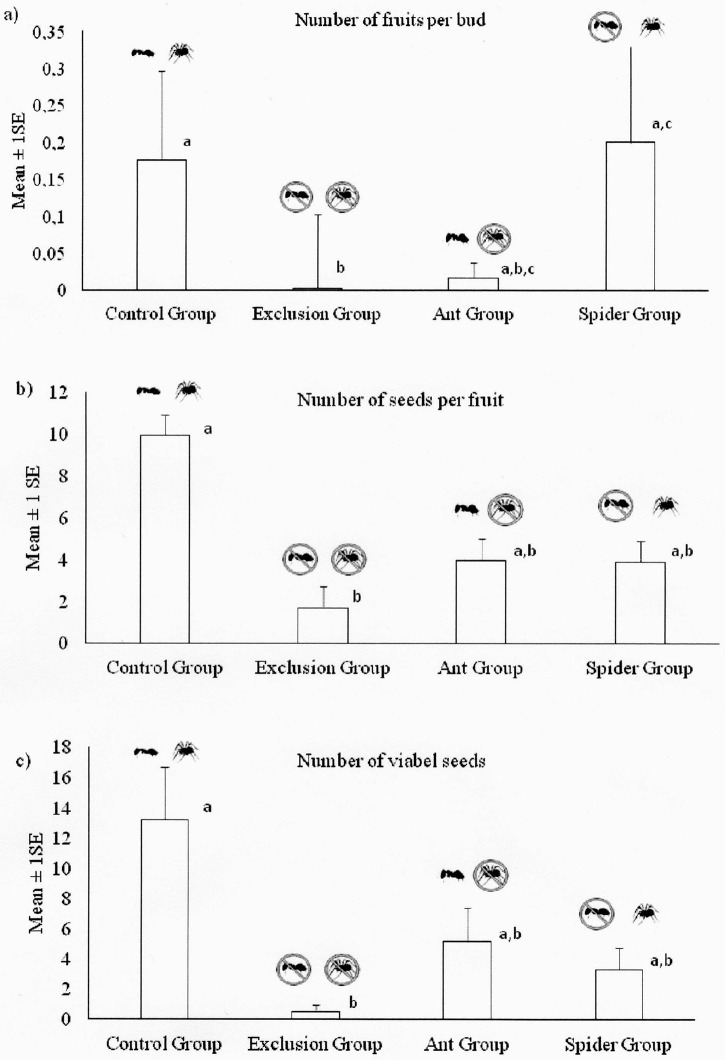
Outcomes of predators on plants.Number of fruits per buds produced (a), number of seed per fruits produced (b) and number of viable seeds (c) in the group ‘Control’—with both predators, ‘Exclusion’–without predators, ‘Ant’–with spiders removed, and ‘Spiders’–with ants removed. Means + 1SE are presented. Different letters over bars point to statistical significant difference (Kruskal-Wallis test, with post-hoc Dunn test; see Table 1).